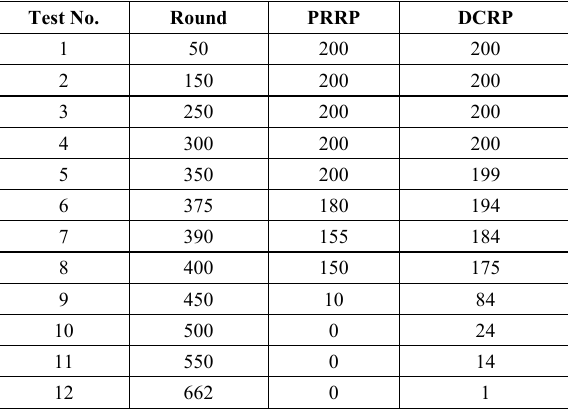
Table 2. Data obtained for DCRP and PRRP protocols in terms of the number live nodes versus time Test No. Round